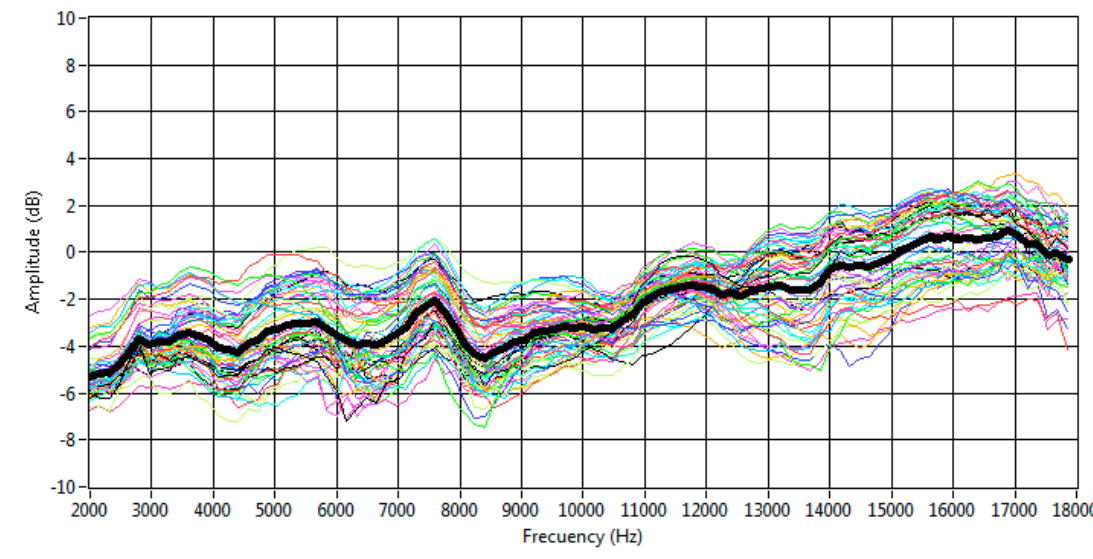
Figure 7. Frequency responses and averaged response of the MEMS microphones.